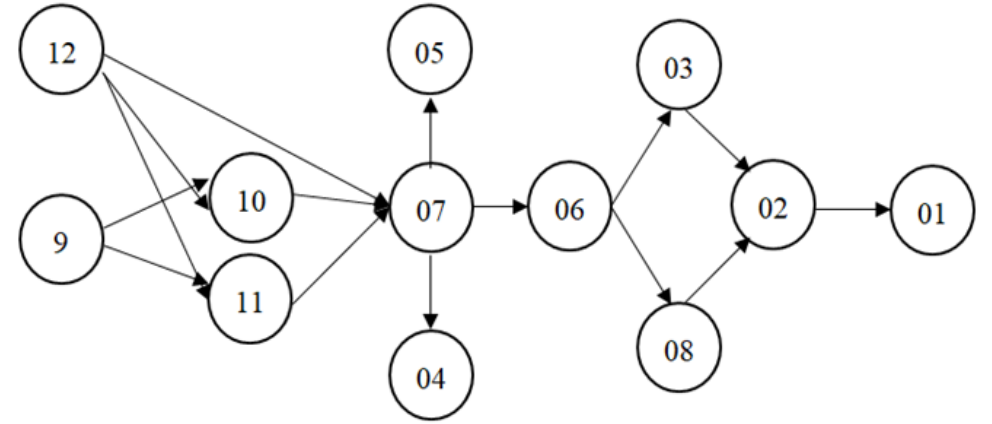
Figure 4. Sequencing of tourist elements to develop tourism in Extremadura. Source: own elaboration based on speech processing with ATLAS.ti software. Table 6. Figure 4 codes interpretation. Figure 4 Code